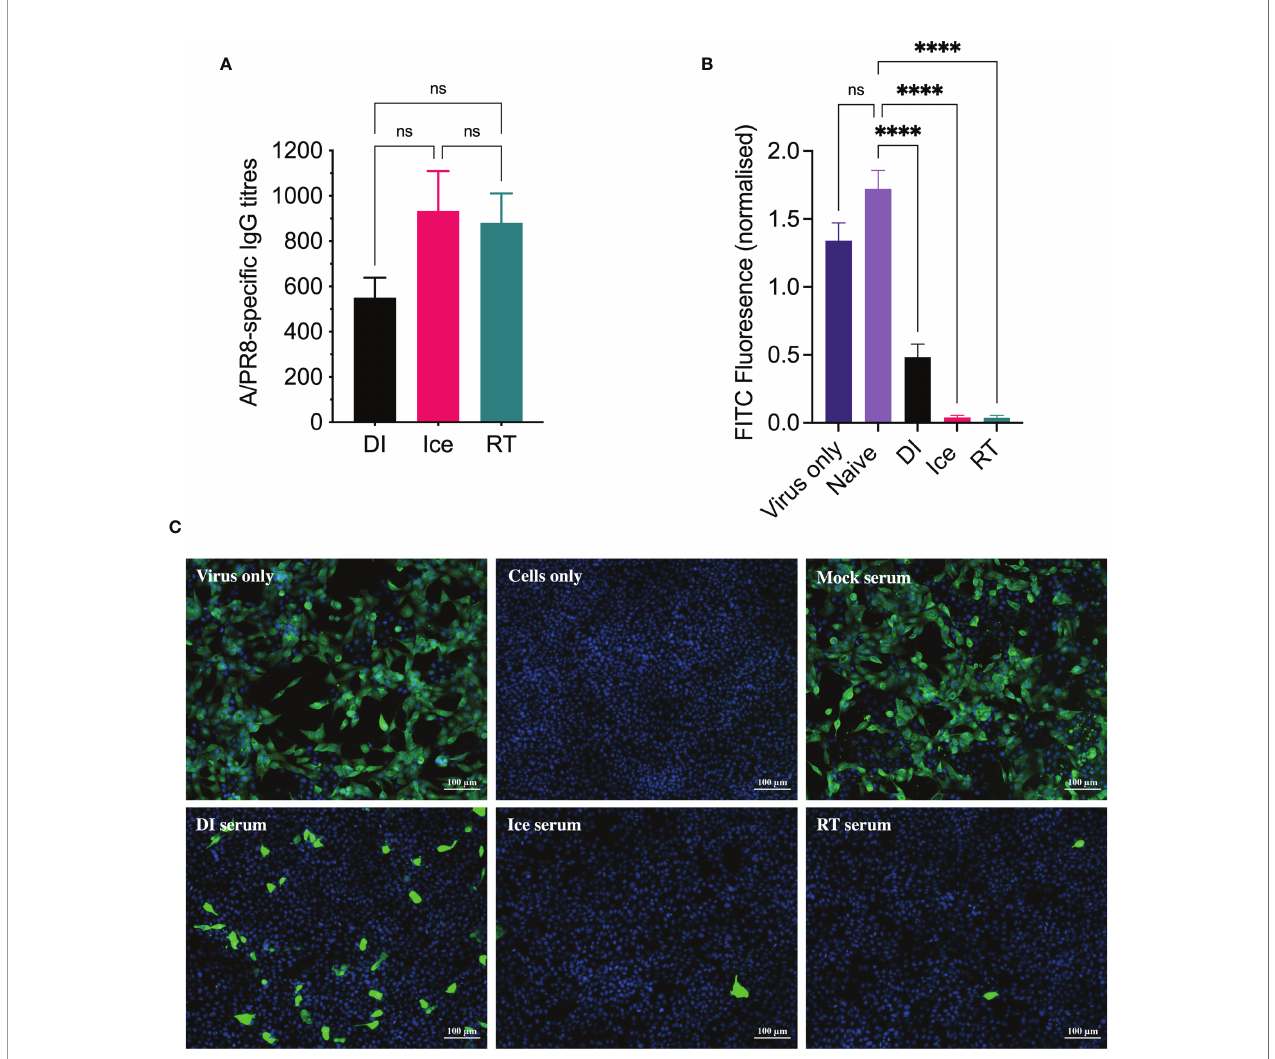
FIGURE 3 | DI- g -Flu induces reduced neutralising antibody responses when compared to Ice- and RT- g -Flu. Mice were vaccinated intranasally with DI- g -Flu, Ice- g - Flu, RT- g -Flu or PBS. Serum samples were collected 20 days post-vaccination. (A) IgG responses were measured by direct ELISA. Data is collated from two independent experiments (n = 5 mice per repeat) and analysed by One-Way ANOVA (not signi fi cant difference). (B) Neutralising antibody responses were measured by FFI. Live virus was treated with pooled naïve serum or pooled immune serum from vaccinated mice (n = 10 serum samples pooled within each vaccine group), then virus:serum mixtures were used to infect MDCK cell monolayers at MOI = 0.1. Each virus:serum mixture was tested in triplicate. FITC- fl uorescence was quanti fi ed as an indicator of IAV infection and was normalised using the corresponding DAPI- fl uorescence in each well (indicates the number of cell-nuclei). Data presented as mean FITC fl uorescence ± SEM and analysed by one-way ANOVA (****p < 0.0001, ns, no signi fi cance). (C) Representative images from FFI assay showing IAV infectivity levels after treatment with pooled naïve and immune serum at a 1:10